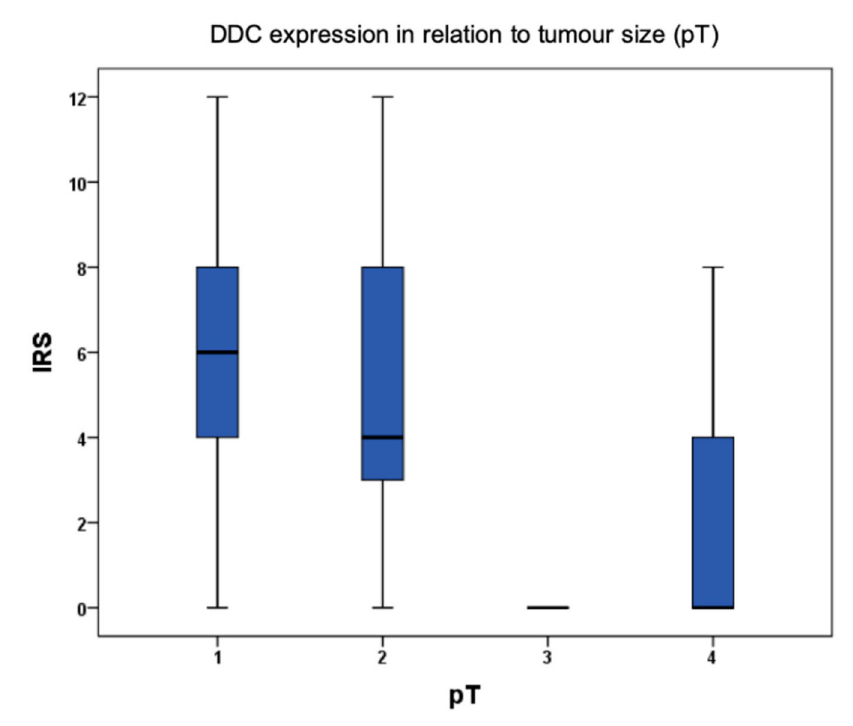
Figure 1. Dopa decarboxylase (DDC) protein expression in breast cancer cells according to tumor size. Boxplot of DDC protein expression in breast cancer in relation to tumor size and correspondent immunoreactive score (IRS) (r = − 0.147; p =